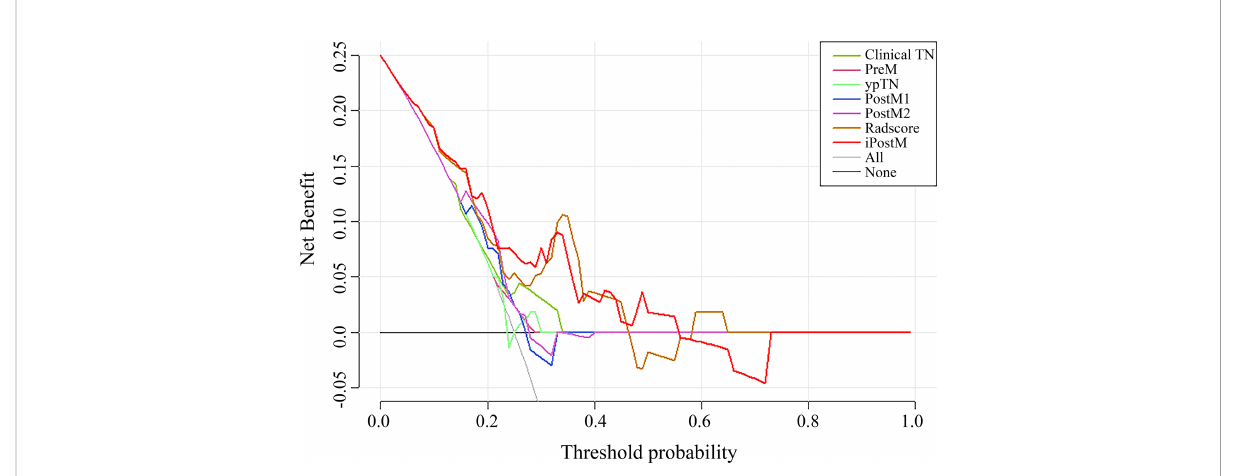
FIGURE 3 The DCA curves of the nomograms compared for 3-year progression-free survival (PFS) in the validation cohort. The x-axis represents the threshold probabilities, and the y-axis indicates the net bene fi t. The net bene fi t is calculated by adding the bene fi ts (true-positive results) and subtracting the risks (false-positive results), with the latter weighted by a factor related to the harm of an undetected cancer relative to the harm of unnecessary treatment. Clinical TN, clinical stage prognostic model; PreM, pretreatment clinical prognostic model; ypTN, pathologic stage prognostic model; PostM1, post-treatment clinical prognostic model; PostM2, post-treatment clinical prognostic model without pathologic stage; iPostM, integrated prognostic model combining tumor regression grade (TRG) and radiomic